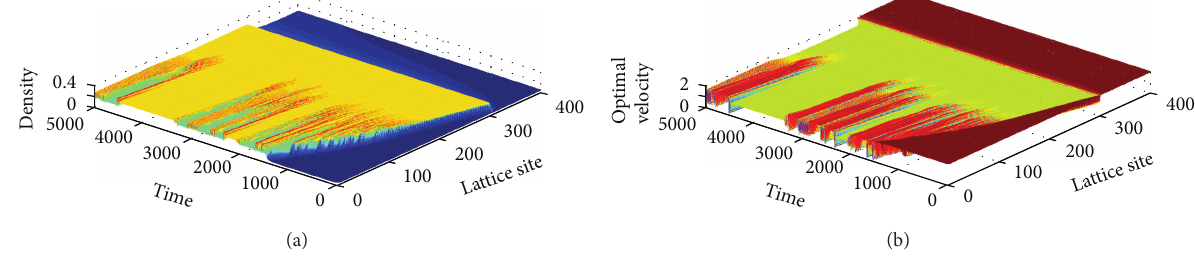
Figure 11: The spatiotemporal evolutions for 𝜌 ℎ = 0.05 , 𝑄 on = 0.18 .